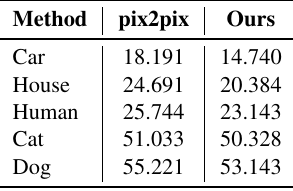
Table 2. Standard deviation of the difference between the real infrared image and the synthesized infrared image in ADU